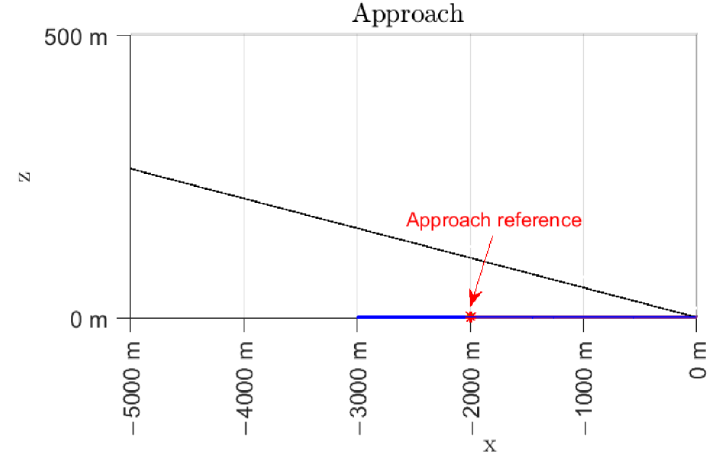
Figure 9. Simulated approach flight path.